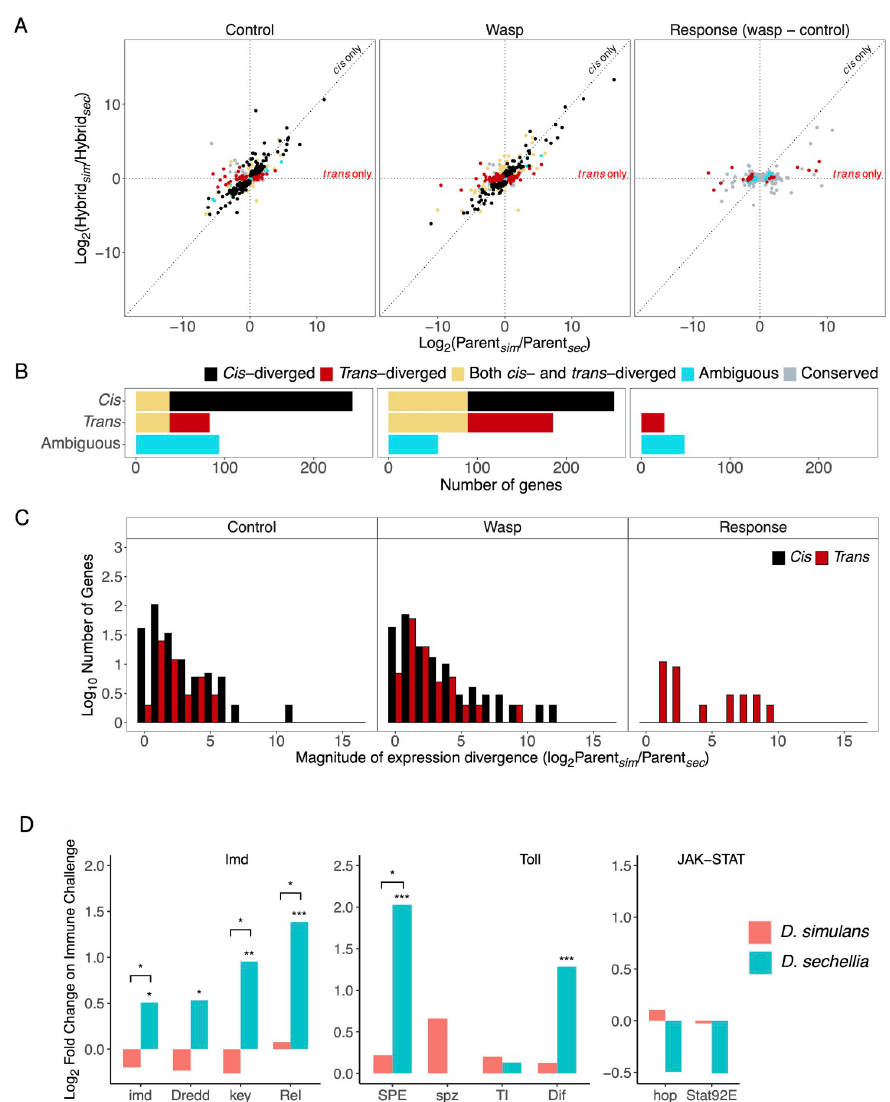
Fig 5. Expression divergence of immune responsive genes between D. simulans and D. sechellia in the fat body. Plots only show genes that are significantly differentially expressed in response to infection in at least one species. (A) Expression differences between parental species plotted against allelic expression differences within F1 hybrids ( cis- regulatory divergence). Gene expression was measured under unchallenged control conditions (left) and immune- challenged conditions (centre), and this was used to estimate the expression change in response to immune challenge (right). (A and B) The genes are colour coded according to whether gene expression divergence is controlled in cis or in trans , with panel (B) depicting the number of genes in each category. (C) Histograms depicting the frequencies of cis- and trans- diverged genes with differing expression divergence between D. simulans and D. sechellia . (D) Changes in the expression of immunity genes encoding components of major humoral immune response signalling pathways in the fat body after immune challenge. Bars represent the change in gene expression 24 hours after injection with mineral oil containing wasp homogenate. Significantly differentially expressed genes within each species were indicated by � on top of columns. Divergent gene expression change responding to immune challenge between D. simulans and D. sechellia was indicated by � on top of bars between columns. Significance level was defined by false discovery rate (FDR): 0.05 � , 0.01 �� , 0.001 ��� .